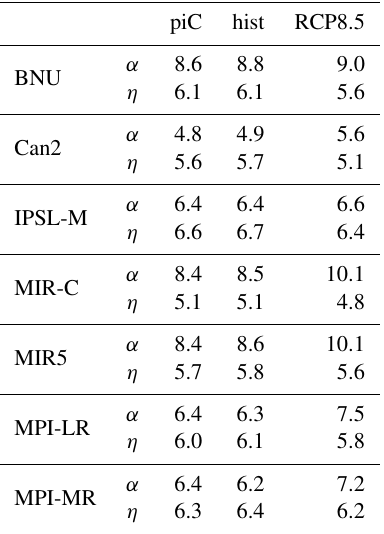
Table 10. The 20-year annual mean irreversibility and baroclinic efficiency for each model and each scenario. Baroclinic efficiency is rescaled as 10 − 2